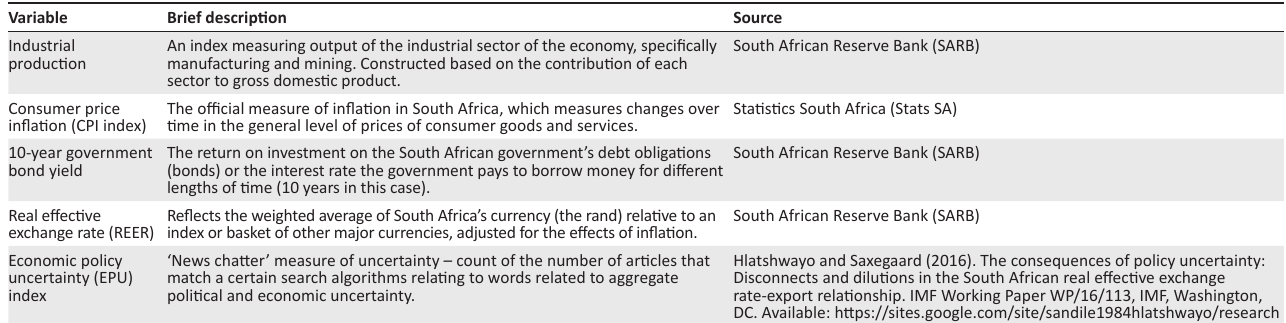
TABLE 1-A1: List of variables used in analysis.